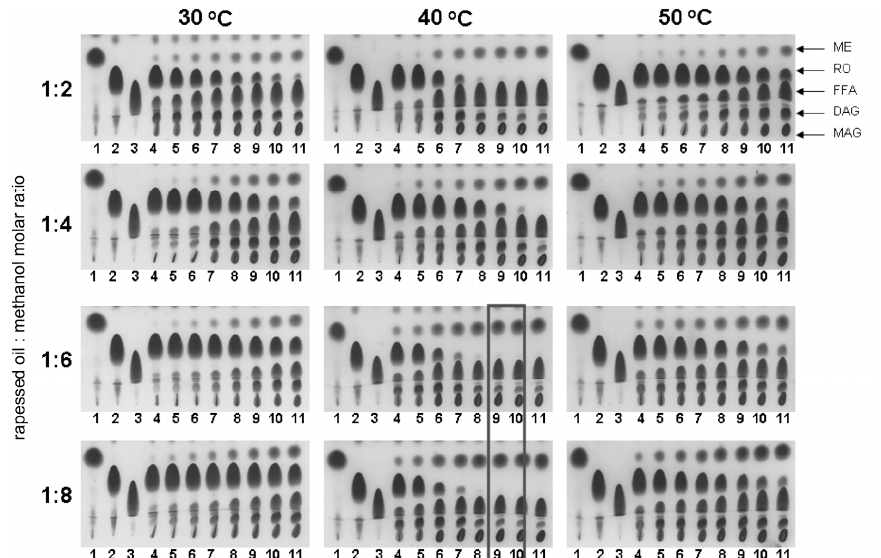
Fig. 6. Thin layer chromatogram of effect of molar ratio of substrates, reaction temperature and time on reaction products of Lipoprime 50T-catalyzed rapeseed oil methanolysis in t -butanol. Visualization was by iodine vapour. Identification was by comparison with stan- dards (lane 1 – methyl oleate, lane 2 – rapeseed oil, lane 3 – oleic acid). Solvent system: 85:15:2. The chromatographic view of reaction products after: 15 min – lane 4; 30 min – lane 5; 45 min – lane 6; 1 h – lane 7; 1.5 h – lane 8; 2 h – lane 9; 3 h – lane 10; 4 h – lane